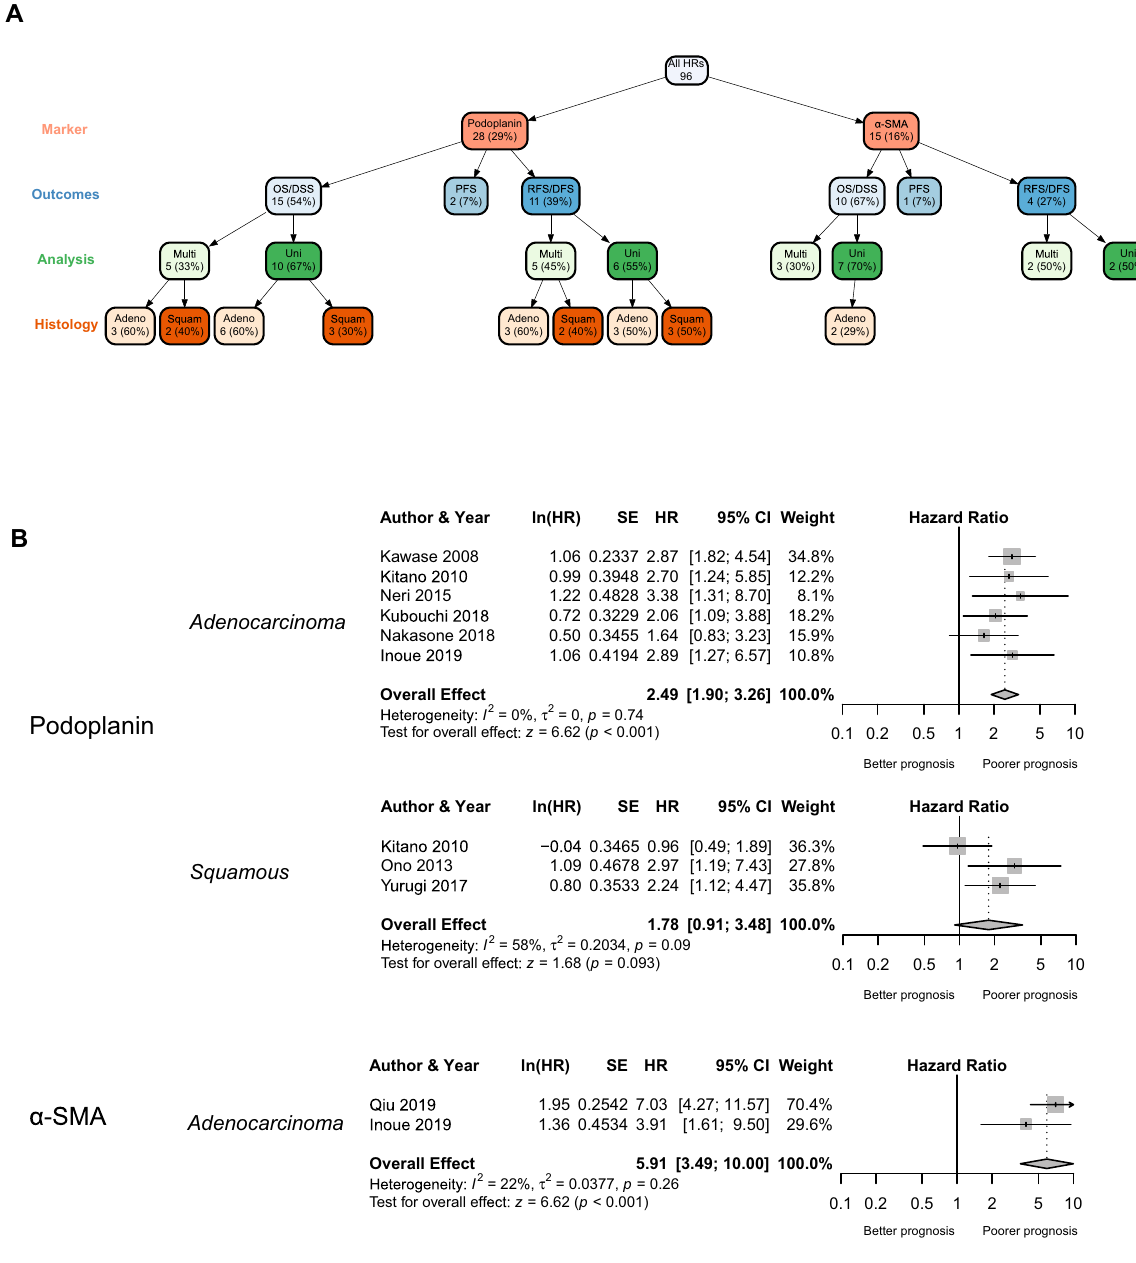
Figure 3. Sub-group analysis of individual markers based on histological subtype. ( A ) Tree network showing number of studies for each marker per outcome group, analysis method and histological subtype. Figure generated using the vtree package in R (version 3.5.2). ( B ) Random-effect forest plots of individual markers from the OS/DSS outcome group and univariate analysis method with histological subtype